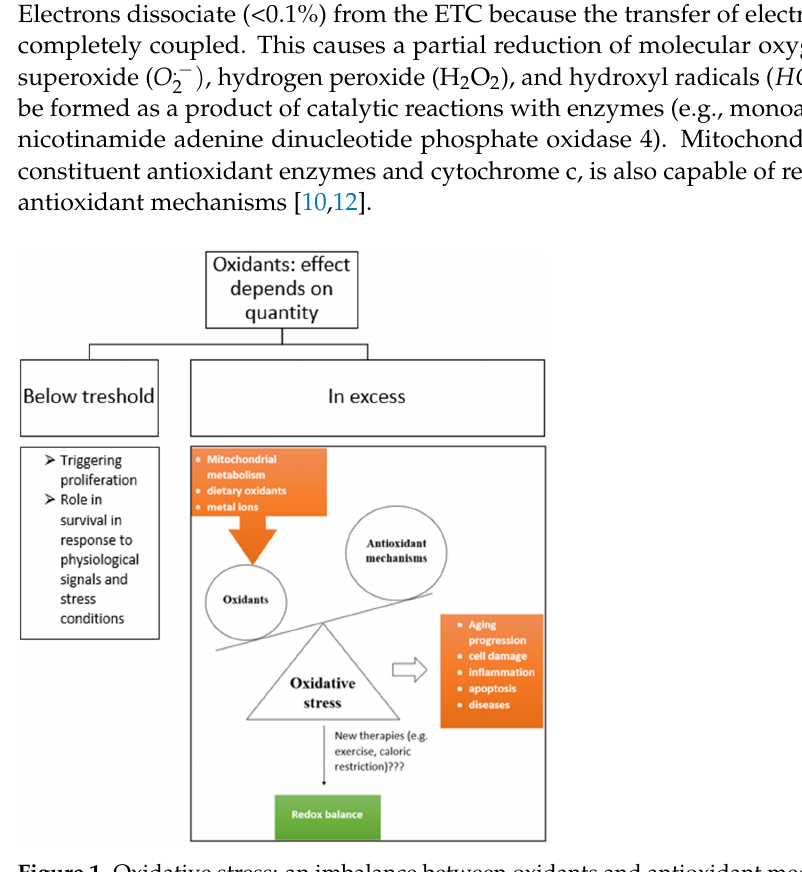
Figure 1. Oxidative stress: an imbalance between oxidants and antioxidant mechanisms in favor of the oxidants. Oxidants are formed due to mitochondrial metabolism, dietary oxidants, and metal ions [14]. In low-to-moderate quantities, oxidants have important functions in the body, such as triggering proliferation or survival responses to physiological signals and stress conditions. However, in excess, they provoke oxidative stress [15]. The oxidative stress results in various pathologies. Different therapies, such as exercise or caloric restriction, are being studied to understand how they might lower oxidative stress and restore redox